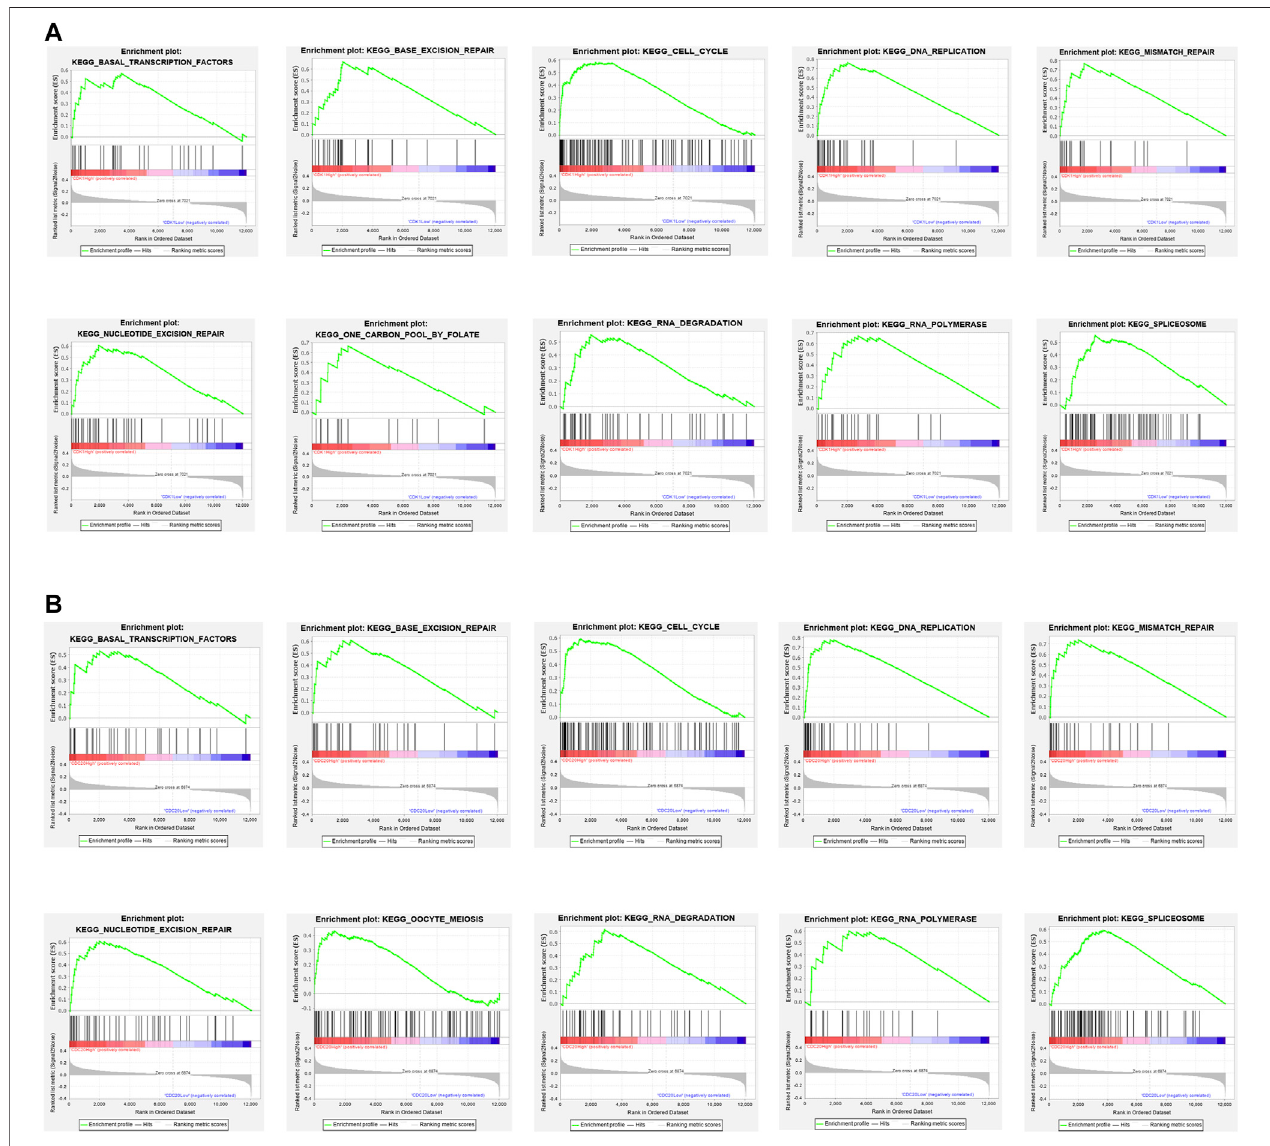
FIGURE 6 | Enrichment plots by GSEA. Relative pathways associated with the expression of CDK1 (A) are displayed. Relative pathways associated with the expression of CDC20 (B) are displayed.